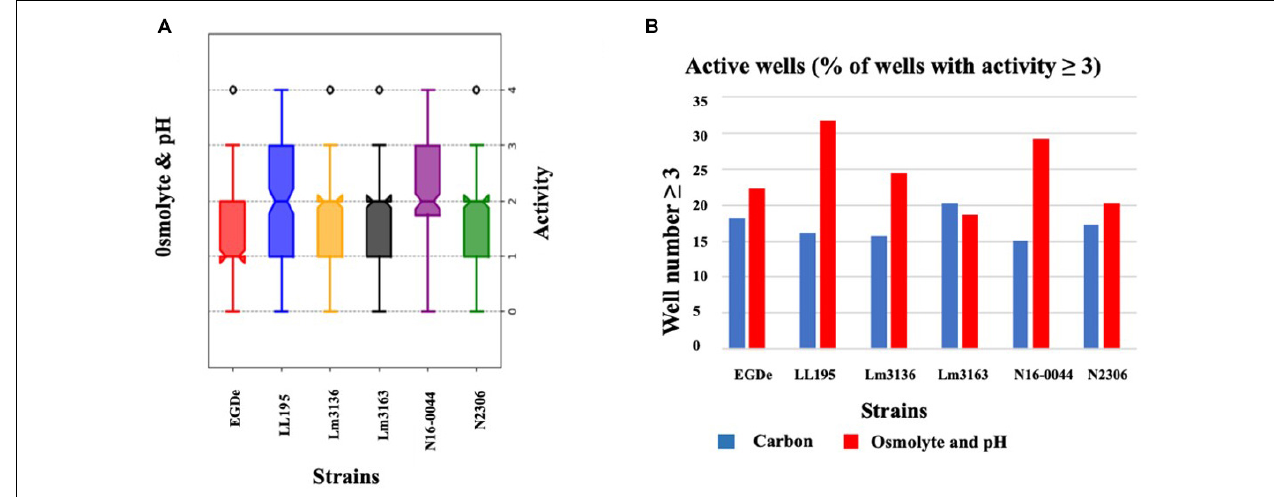
FIGURE 2 | Variation of C-source utilization and stress tolerance profiles among L. monocytogenes strains. (A) Box-plot showing growth/metabolic activities observed among the study strains under pH and osmotic stress conditions. (B) Bar graph displaying the percentage of compounds under which each strain had an activity that equaled or was above 3 AV.